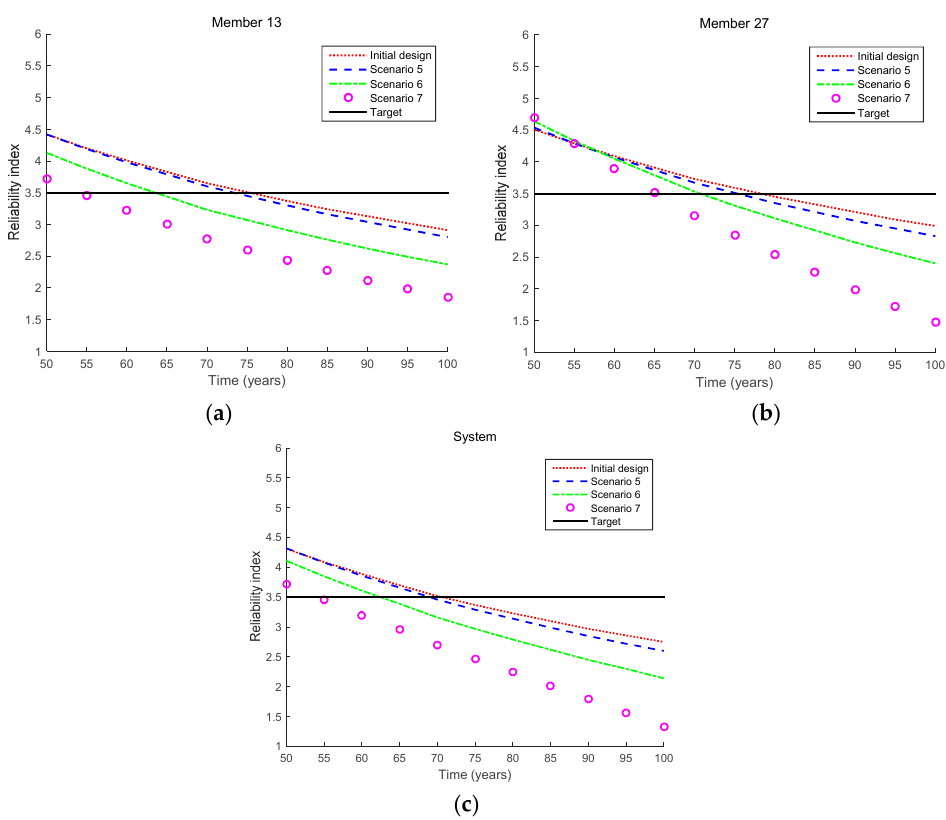
Figure 9. Reliability updating results by the proposed method for inequality cases (Scenarios 5–7 in Table 3). ( a ) Scenario 5; ( b ) Scenario 6; ( c ) Scenario 7.